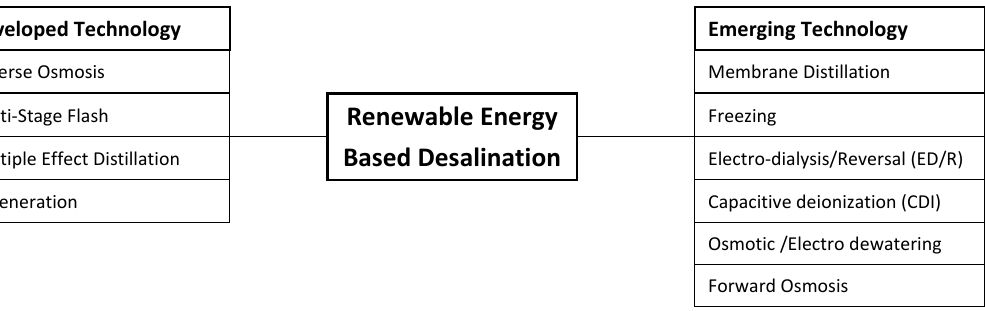
Figure 6. Comparison of performance and price range of PV technologies [52].